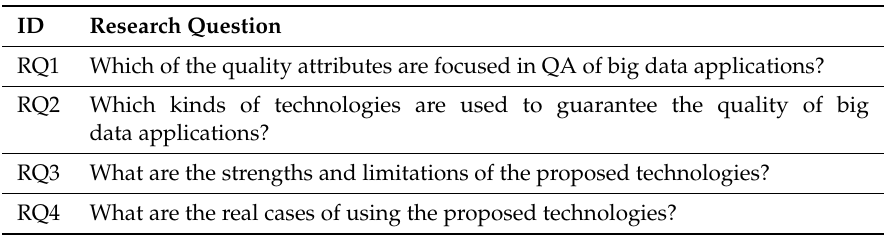
Table 3. Research questions.